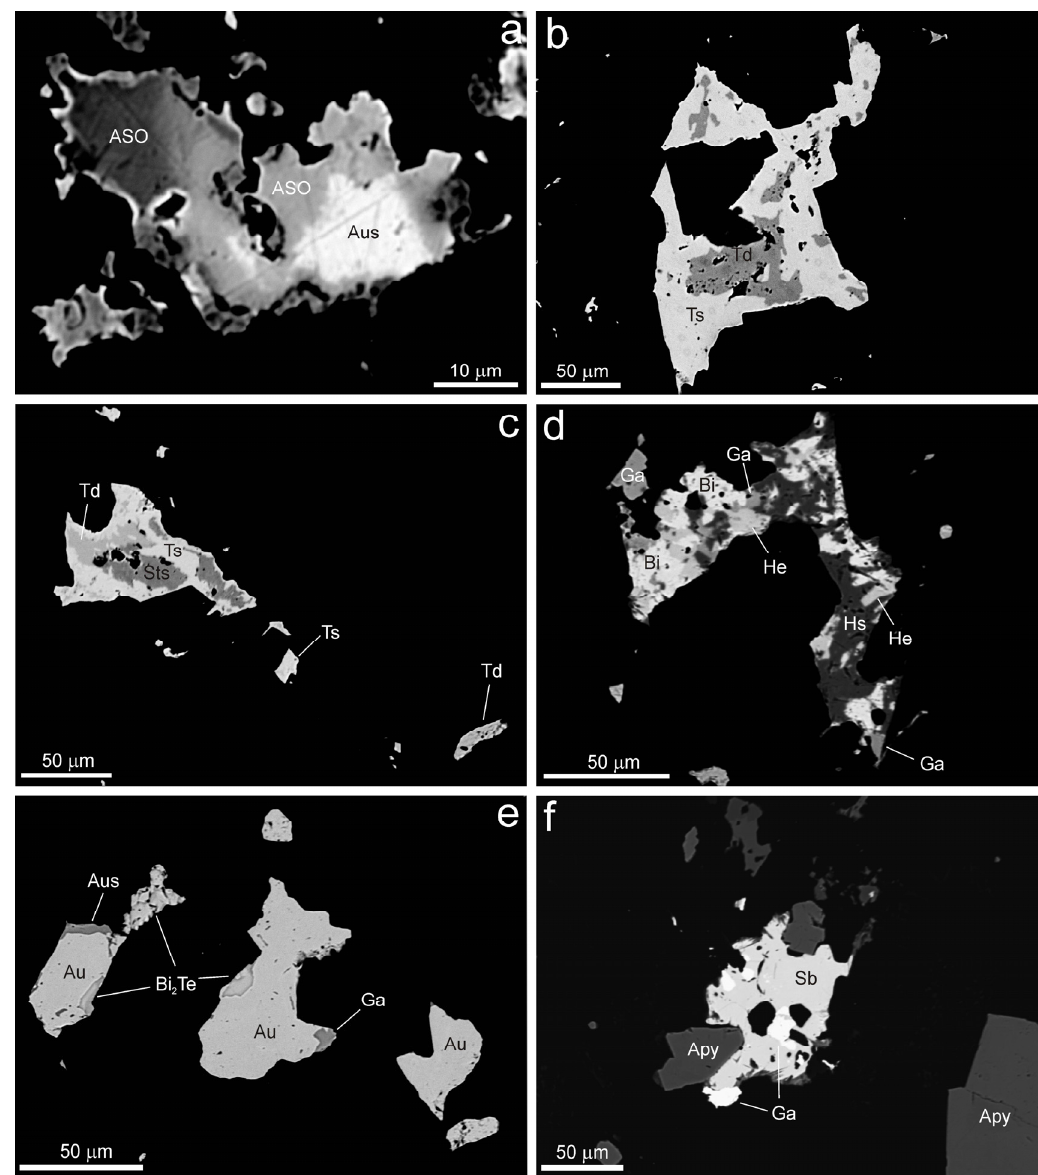
Figure 8. Textures of some ore minerals of the studied Au-bearing vein in BSE images: ( a ) Relic of aurostibite (Aus) replaced by an unnamed strongly zoned (Au,Ag)-Sb oxide (ASO). ( b ) An aggregate of Bi-tellurides composed of tetradymite (Td) rimmed by tsumoite (Ts). ( c ) An aggregate of Bi-tellurides composed of sulphotsumoite (Sts), tetradymite (Td), and tsumoite (Ts). ( d ) Mineralogically rich ore aggregate composed of native bismuth (Bi) rimmed by hedleyite (Hs), galena (Ga), and hessite (He). ( e ) High-fineness gold (Au) grains slightly replaced by aurostibite (Aus), galena (Ga), and an unnamed Bi 2 Te (Bi 2 Te). ( f ) Intergrowth of galena (Ga) and native antimony (Sb) growing over arsenopyrite (Apy).